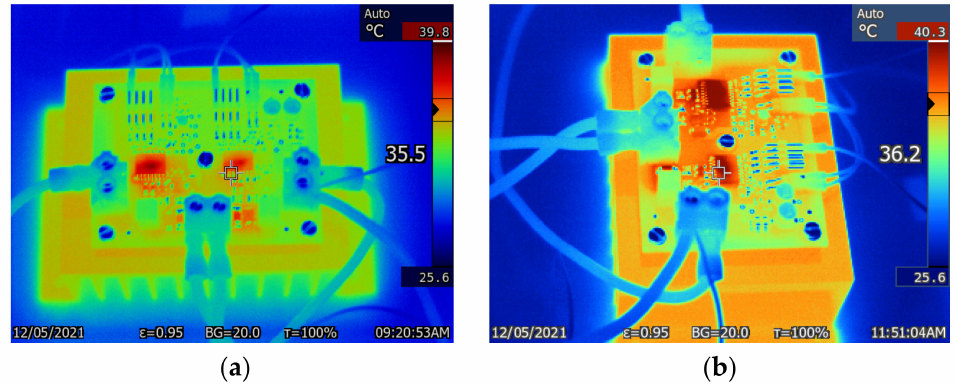
Figure 17. Temperature distribution of an HB cell with 50% of the nominal load: ( a ) after 30 min of operation; ( b ) after 3 h of